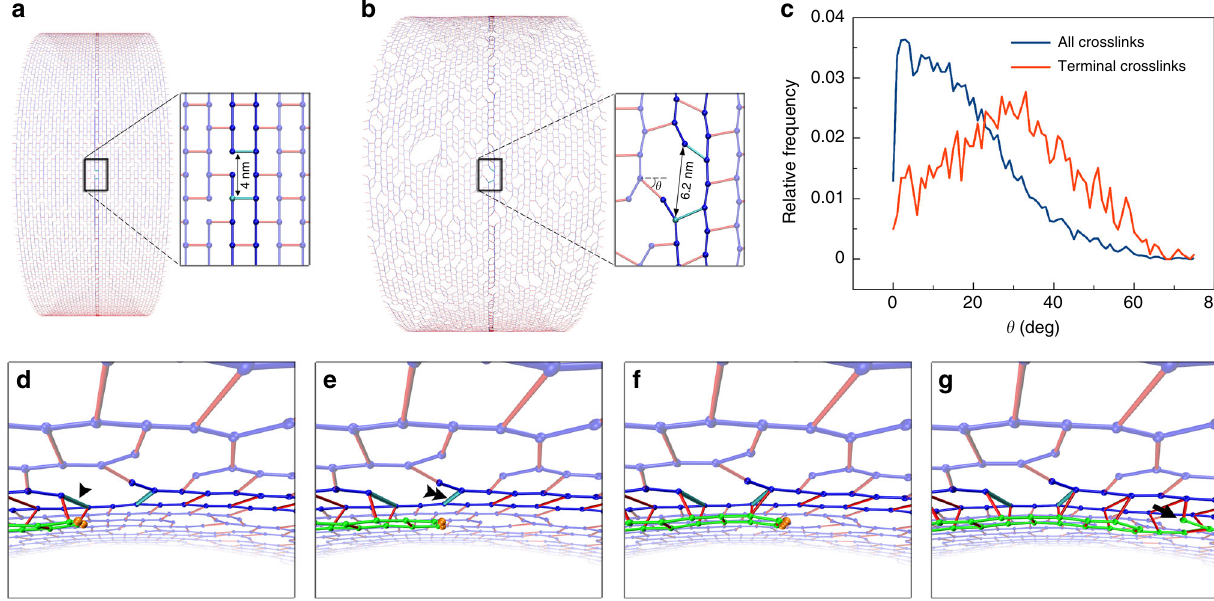
Fig. 5 Effect of turgor pressure on the make-before-break mechanism. Two adjacent peptide crosslinks at a glycan break in a hoop are highlighted in cyan for visualization. a Without turgor pressure, the peptidoglycan (PG) was well ordered and the distance between the highlighted crosslinks was 4 nm. b Under turgor pressure, the cylinder expanded, peptides tilted, and the distance between the highlighted crosslinks increased to ~6.2 nm. θ depicts the tilting angle of a peptide crosslink. c Histogram of the tilting angles of all the peptide crosslinks (blue) and those connecting glycan termini (red). d An oblique view showing insertion of two new glycan strands in a make-before-break mechanism. When the new strand tips reach the fi rst cyan-highlighted crosslink (indicated by the arrow head), they get ~0.4 nm ahead of their templates. e At the second cyan-highlighted crosslink (indicated by the double arrowhead), this small gain is offset by the additional 2.2 nm enlargement of the distance between the two crosslinks. f After the second highlighted crosslink, the strand tips fall behind their templates. g A break in the new glycan strands (indicated by the arrow) pulls the new strands forward, preventing them from falling behind their